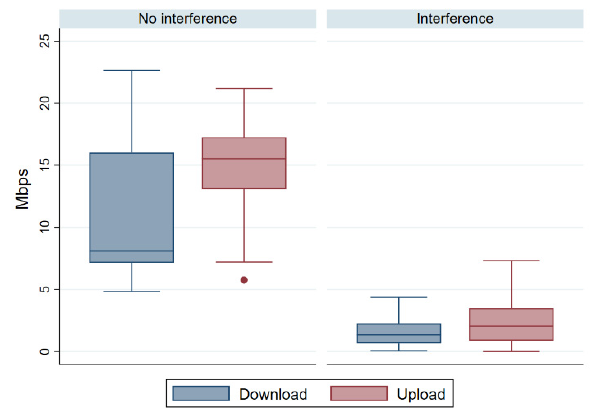
Figure 9. Tukey box plot of down- and upload throughput. The horizontal line drawn through the rectangles represents the median, while the upper and lower edges of the rectangles represent the interquartile range. Table 3. Tests of skewness or kurtosis in measurements of down- and upload throughput.